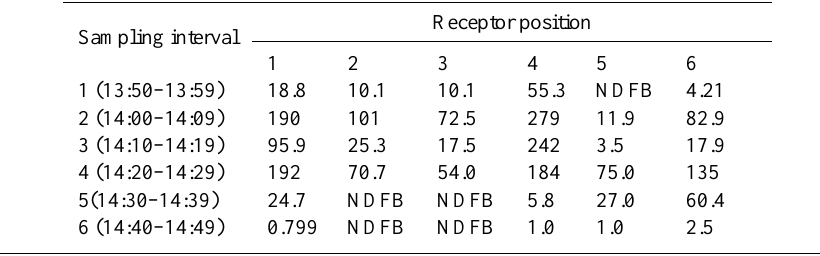
Table 2. Tracer data at various receptor positions (See Fig. 1 for location) during REPARTEE I and II. (NDFB- Non discernible from